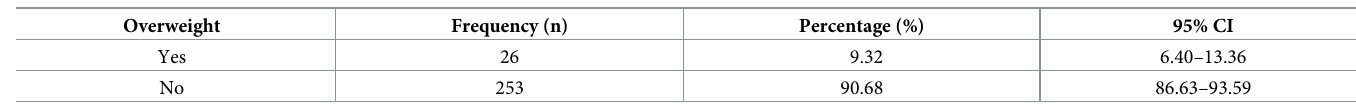
Table 2. Anthropometric assessment of adolescents (n = 279).